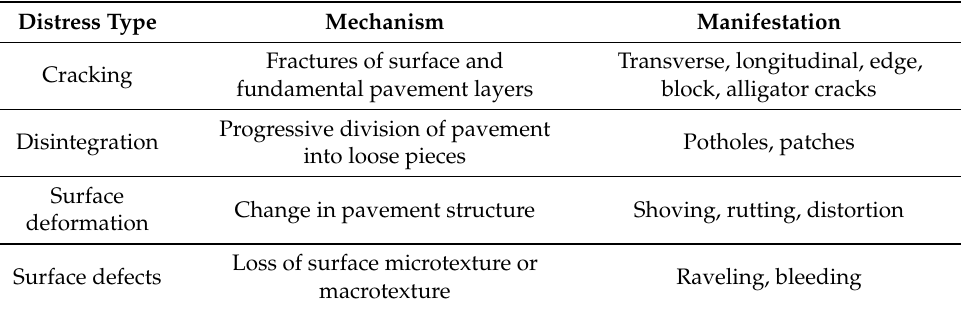
Table 1. Pavement distress types